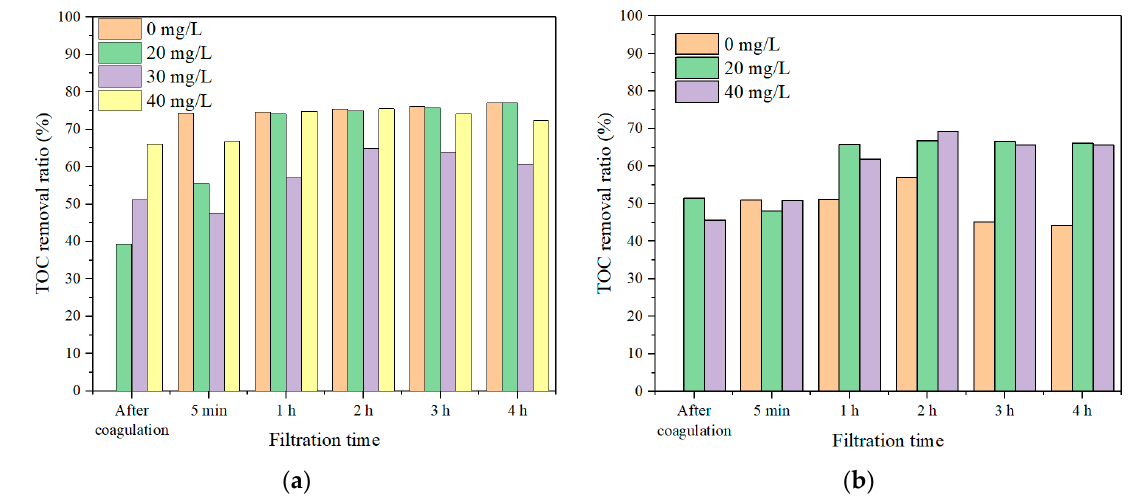
Figure 8. TOC removal ratios with a rotation speed of 30 r/min and different coagulant dosages, ( a ) SA, and ( b ) TA.